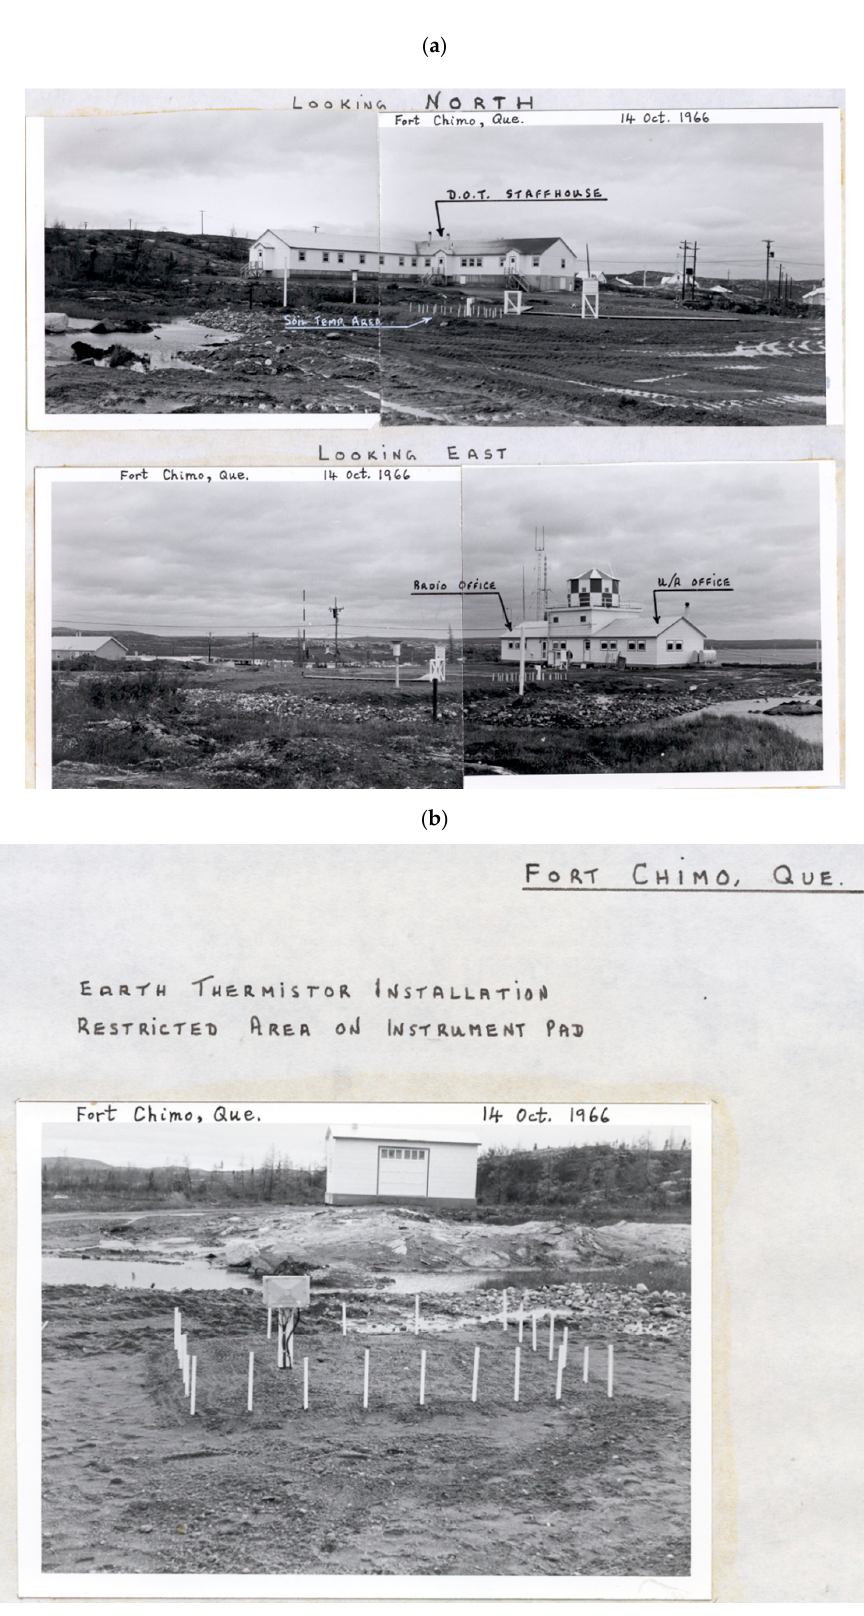
Figure 2. Photographs taken during the installation of earth thermistors by Environment Canada’s staff at Kuujjuaq (formerly known as Fort Chimo) on 14 October 1966 [19]. The pictures depict ( a ) the surrounding environment and the buildings of the weather station; ( b ) the location and ground conditions where the soil temperature instruments were